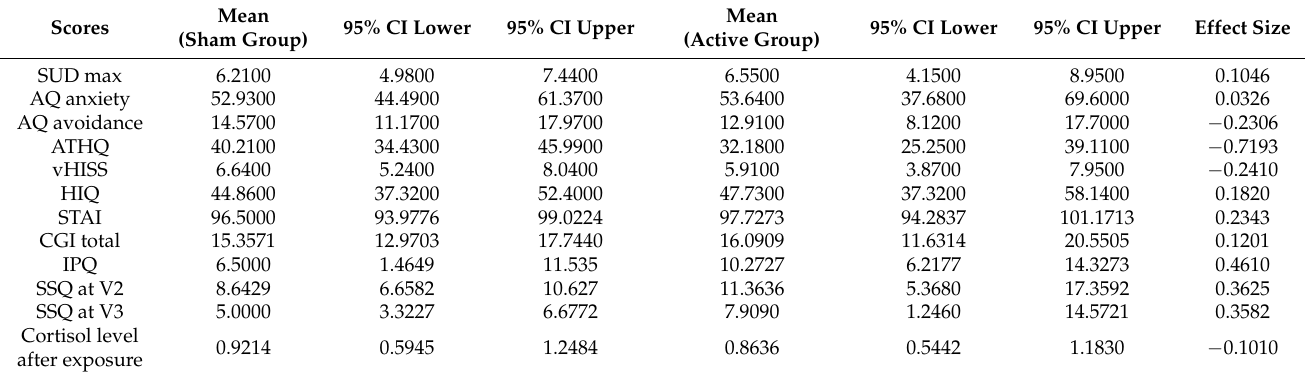
Table 3. Mean difference between groups for each score at V4 (with 95% CI and effect size).